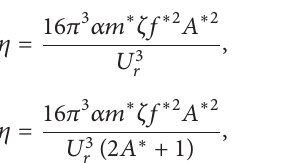
where 𝛼 represent different cross sections. For the circular cylinder, 𝛼 is 𝜋/2 ; for the regular triangle prism, 𝛼 is √3/4 ; for right square or diamond prism, 𝛼 is